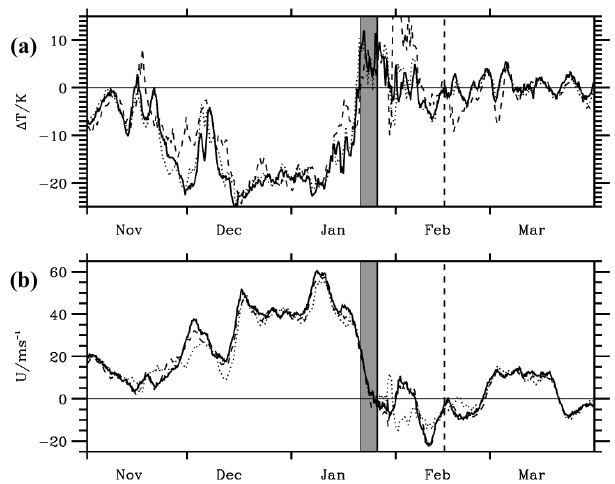
Fig. 4. Criteria of a major warming: time series of 120h forecasts at Figure 4: Criteria of a major warming: Time series of 120 h forecasts at 10 hPa of the 2 10hPa of the meridional temperature difference (a) and the zonally meridional temperature difference (a) and the zonally averaged zonal velocity at 60 °N (b) for 3 averaged zonal velocity at 60 ◦ N (b) for the winter 2009/2010. Re- the winter 2009-2010. Results are shown for high-resolution deterministic (dotted lines) and 4 sults are shown for high-resolution deterministic (dotted lines) and lower-resolution EPS control forecasts (dashed lines). Also shown is the verifying operational 5 lower-resolution EPS control forecasts (dashed lines). Also shown analysis (solid lines). Δ T is computed from zonally averaged temperature differences between 6 is the verifying operational analysis (solid lines). 1T is computed 85 °N and 60 °N. The grey shaded column marks the 5 day period after the mean temperature 7 from zonally averaged temperature differences between 85 ◦ N and gradient between 85 °N and 60 °N is positive and the thick solid line marks the central date of 8 60 ◦ N. The grey shaded column marks the 5 day period after the mean temperature gradient between 85 ◦ N and 60 ◦ N is positive and the major warming event on 26 January 2010. The dashed vertical line marks the end of the 9 the thick solid line marks the central date of the major warming 20 day period after the central date of the SSW. 10 event on 26 January 2010. The dashed vertical line marks the end of the 20 day period after the central date of the